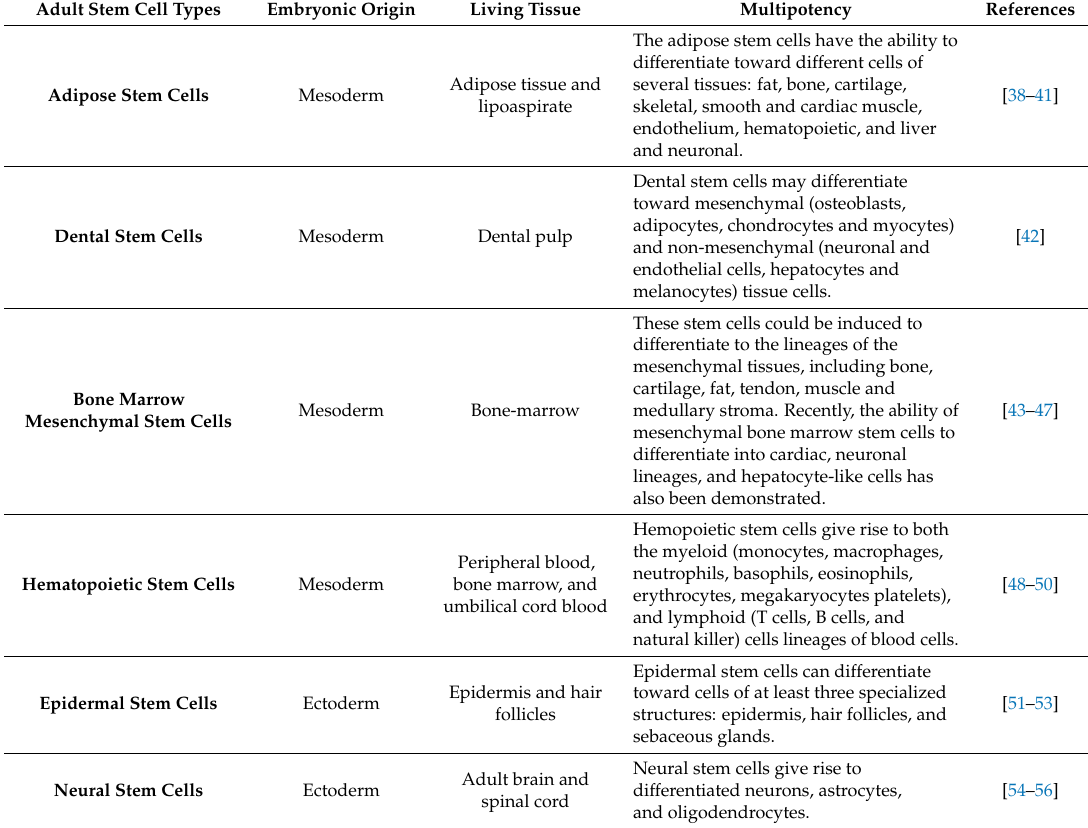
Table 1. Adult stem cell types. The table reports the characteristics of the main types of adult stem